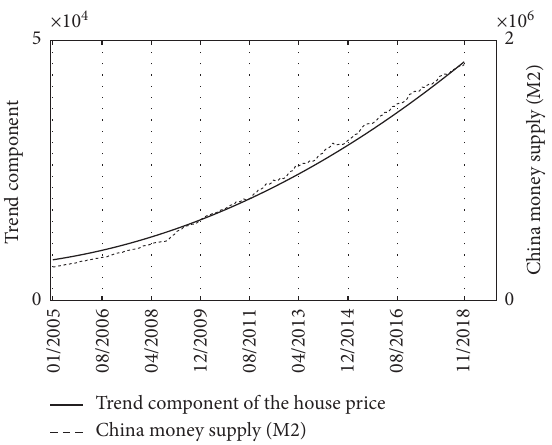
Figure 5: Monthly Chinese money supply (M2) and trend com- ponent of house